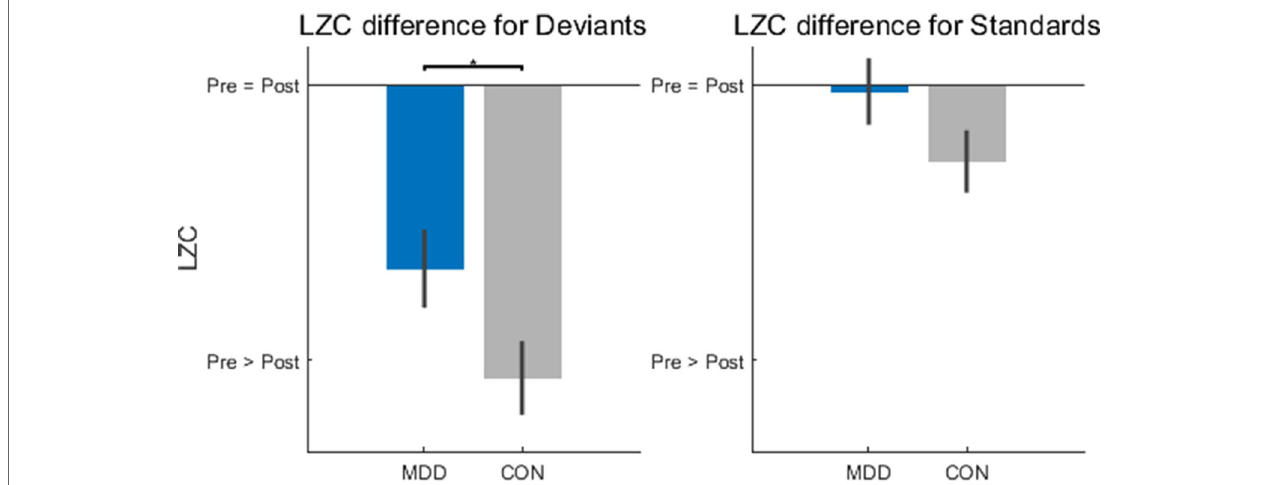
FIGURE 3 | Lempel-Ziv Complexity (LZC) changes after stimulus onset were significantly lower in the MDD group for deviant stimuli. LZC was measured in 300ms time windows before and after stimulus onset. When the difference was calculated (poststim minus prestim), for deviant stimuli the MDD group showed less of a decrease when compared to healthy controls. All p -values are FDR corrected for multiple comparisons. *: <